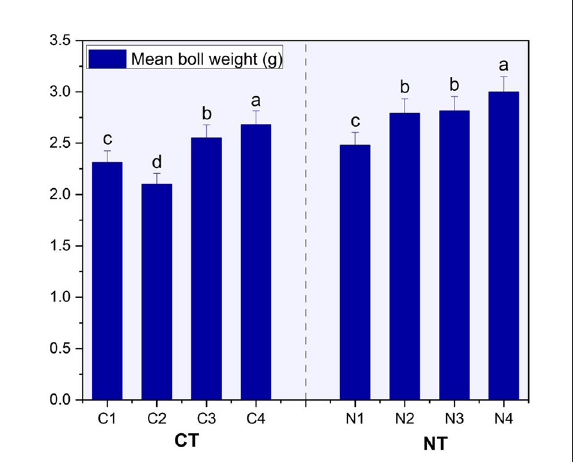
FIGURE4 Interactive effect of intercropping, mulching, and different tillage systems on the mean boll weight of cotton. Other letters above graph bars indicate significant differences at p ≤ 0.05).